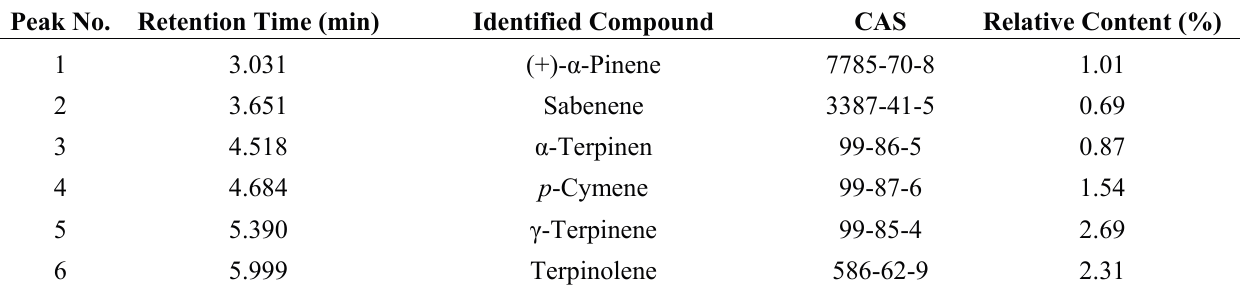
Table 2. Chemical composition of Chuanxiong